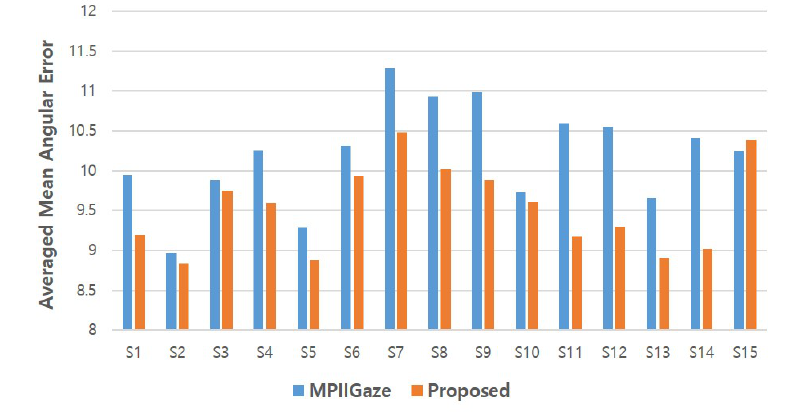
Figure 13. Mean gaze angular error for each subject of the MPIIGaze protocol and the proposed method.